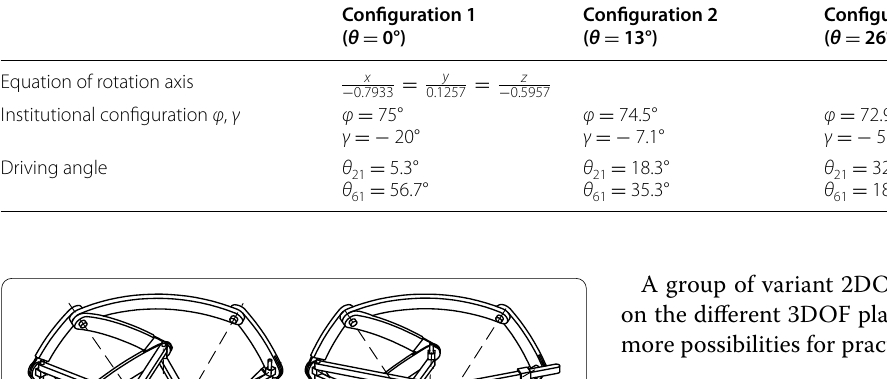
Table 3 Numerical calculation example of the equivalent rotation